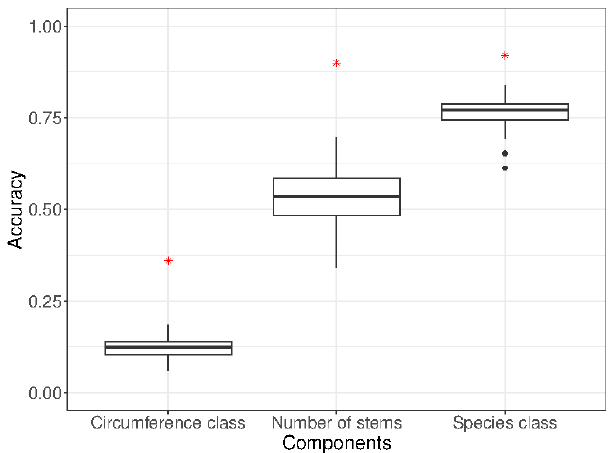
Figure 8. Cross-validation accuracy for the three components. Red stars correspond to the three component accuracy values for the global NN.